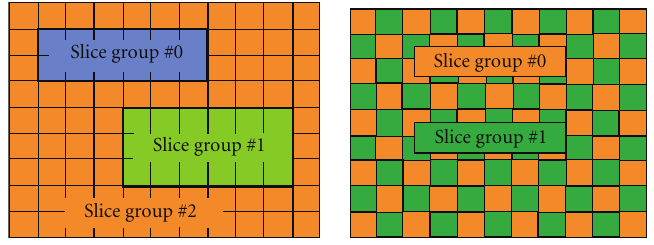
Figure 1: Examples of FMO